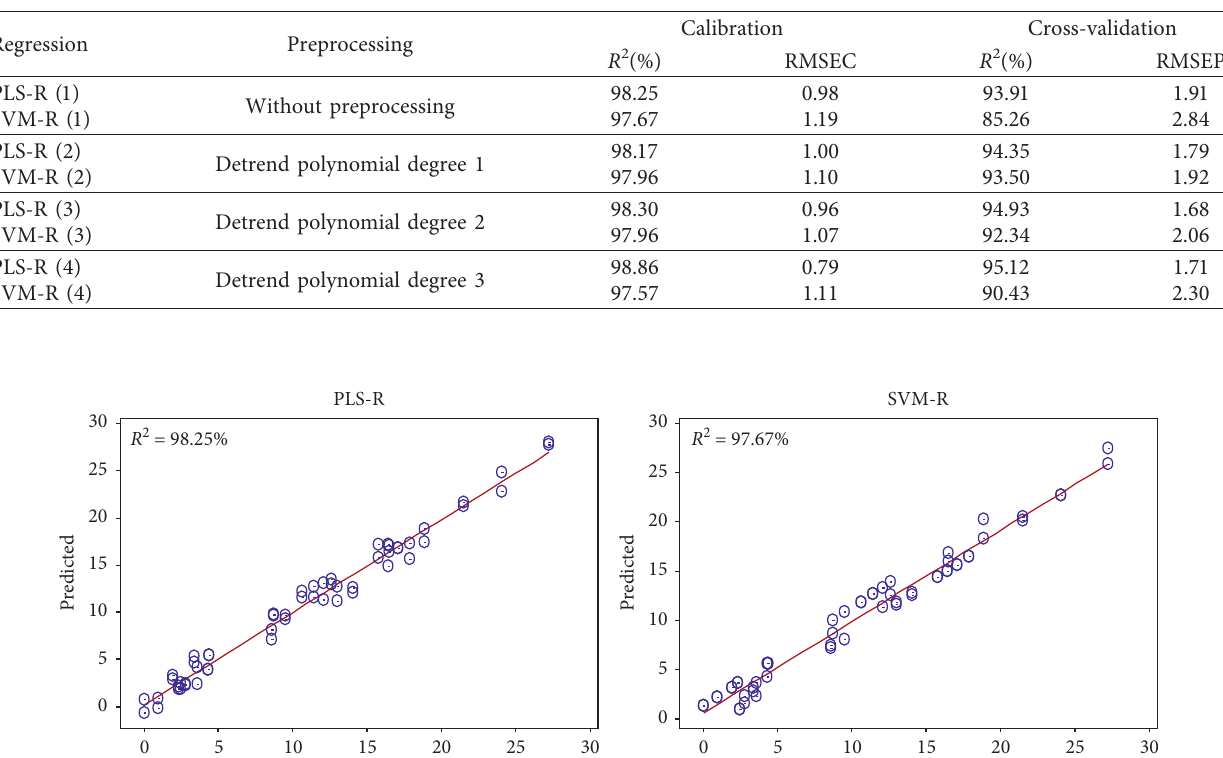
Table 1: Performance parameters of PLS-R and SVM-R.